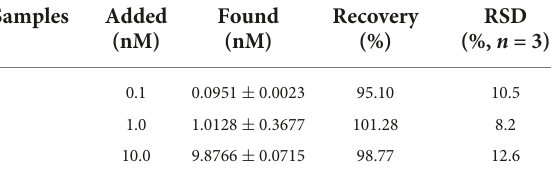
TABLE 1 Detection of the proposed sensor for capture of A β 1 − 42 in serum